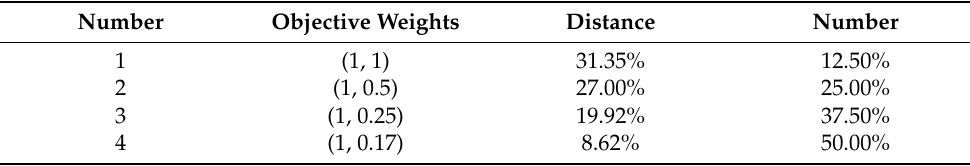
Table 20. Deviations in different solutions in the second